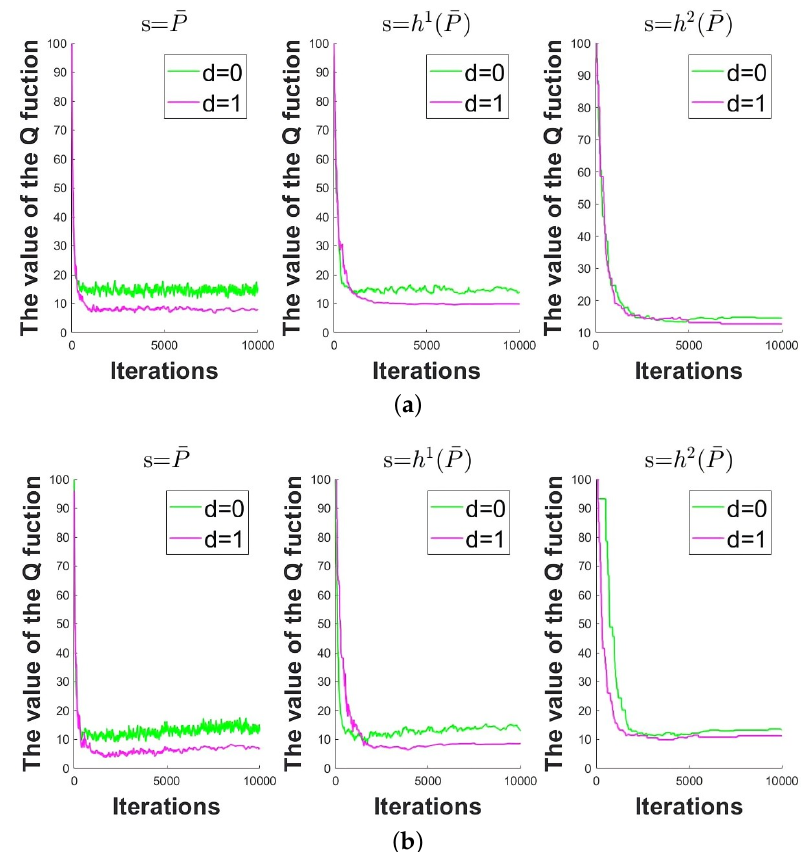
Figure 7. The convergence process of the state-action value Q -function in each state from the perspective of the attacker. ( a ) Based on the framework of Q -learning; ( b ) Based on the framework of